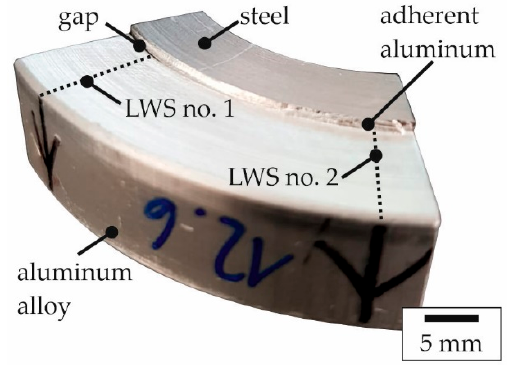
Figure 12. Sample after the shear compression test with adhering aluminum at the level of a longitudinal weld seam (LWS; position marked with arrows and highlighted with dotted lines).